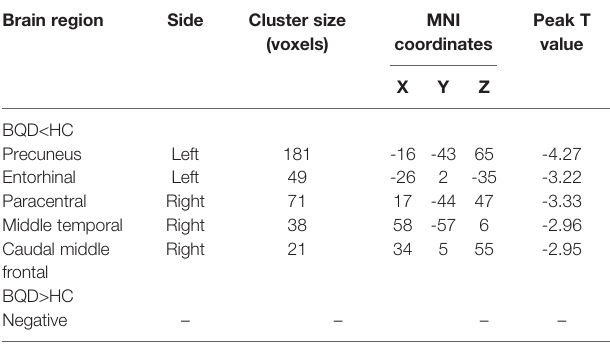
TABLE 2 | Brain regions showing group differences in CT ( p < 0.05, FDR corrected).